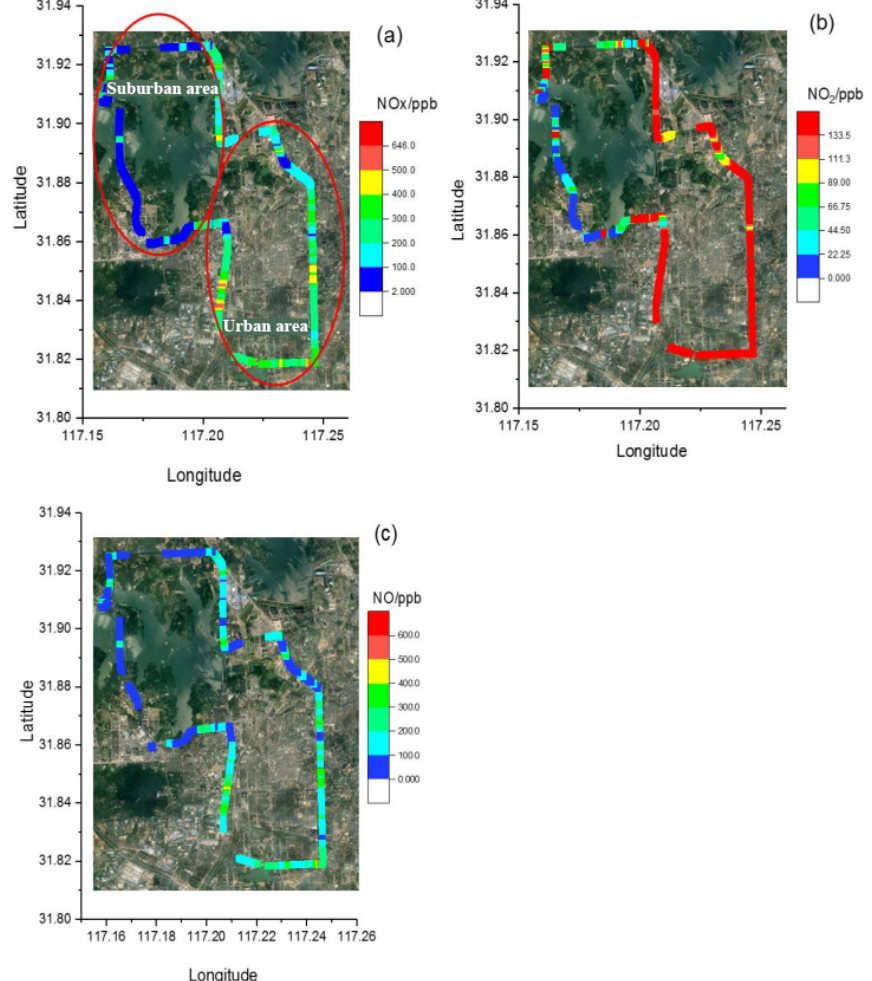
Figure 11. Results of the NO x (a) , NO 2 (b) and NO (c) concentrations around Hefei, China (data are averaged to